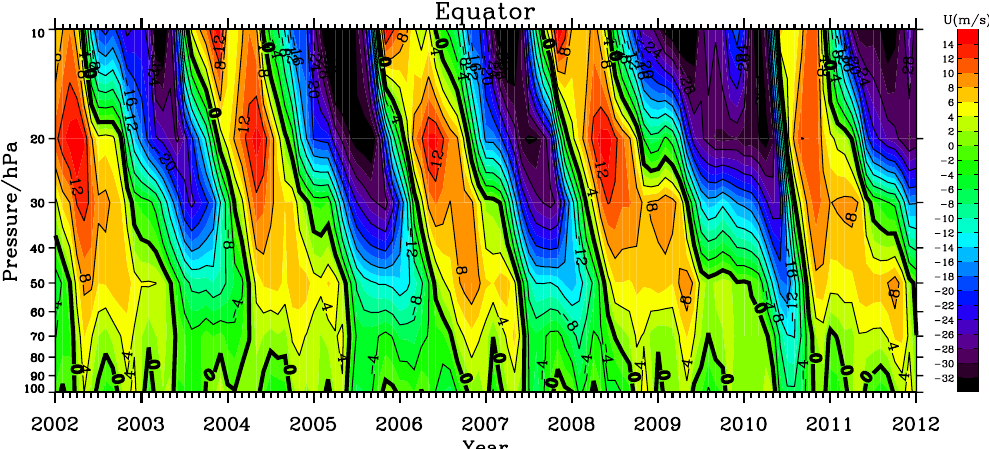
Fig. 8. Monthly zonal mean of the zonal wind at the equator (from 5 ◦ S to 5 ◦ N) from 2002 to 2011 of the NCEP/NCAR reanalysis from 100 to 10hPa, i.e. about